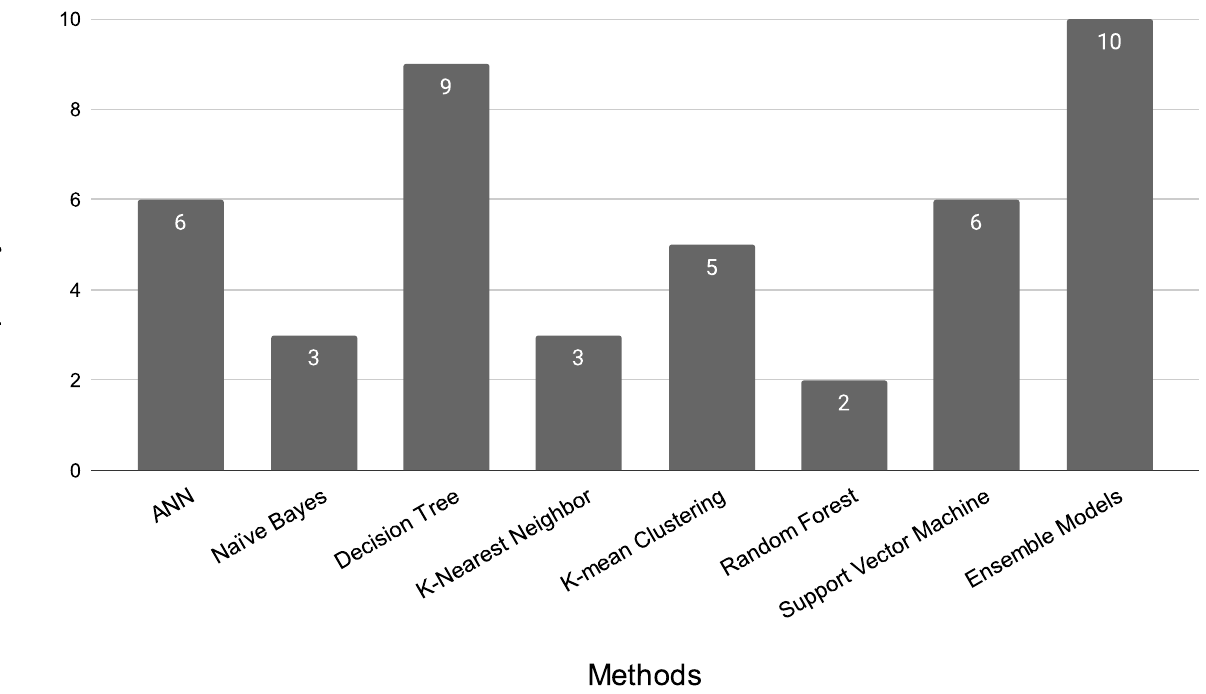
Figure 4. ML models vs. frequency of papers used in this work.